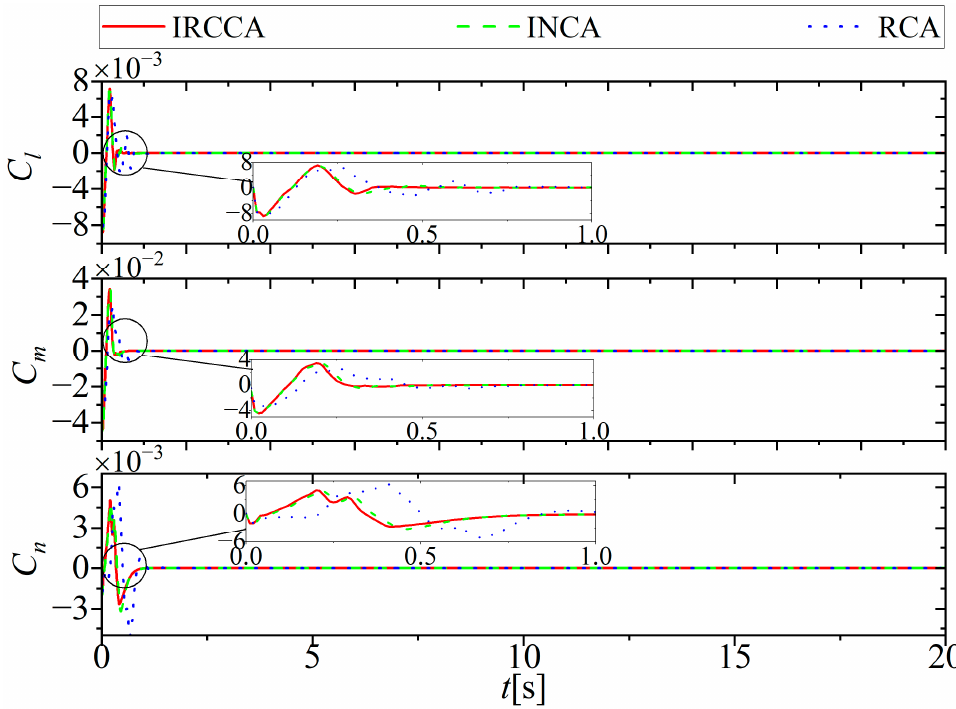
Figure 4. Time response of the moment coefficient with no actuator fault. Table 5. The simulation time with no actuator fault.